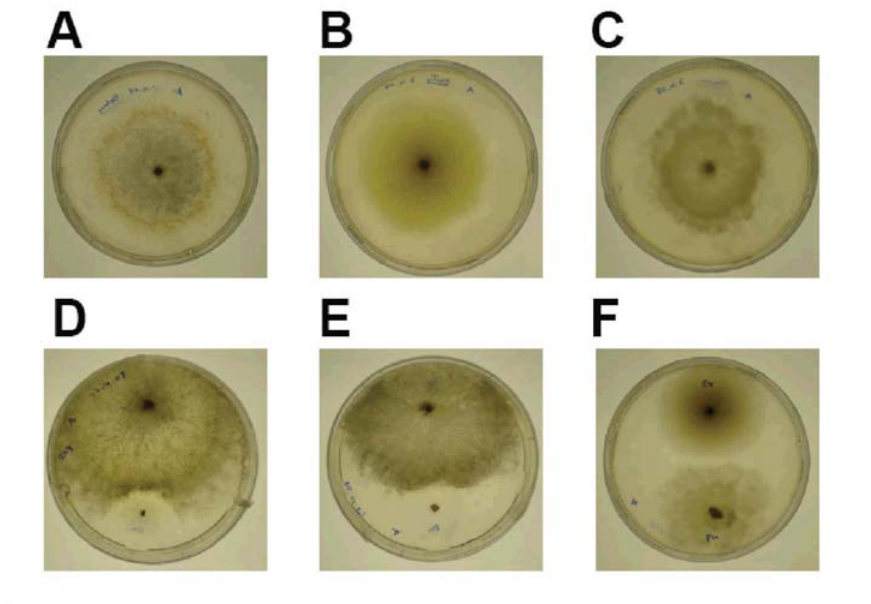
Fig. 4. Peroxide detected with DAB coloration (fungal growth for 4–7 days): (A)- Botryosphaeria parva ; (B) Eutypa lata ; (C) Phomopsis viticola ; and interactions between the fungi: (D) B. parva - E. lata ; (E) B. parva - P. viticola ; (F) E. lata - P. viticola .